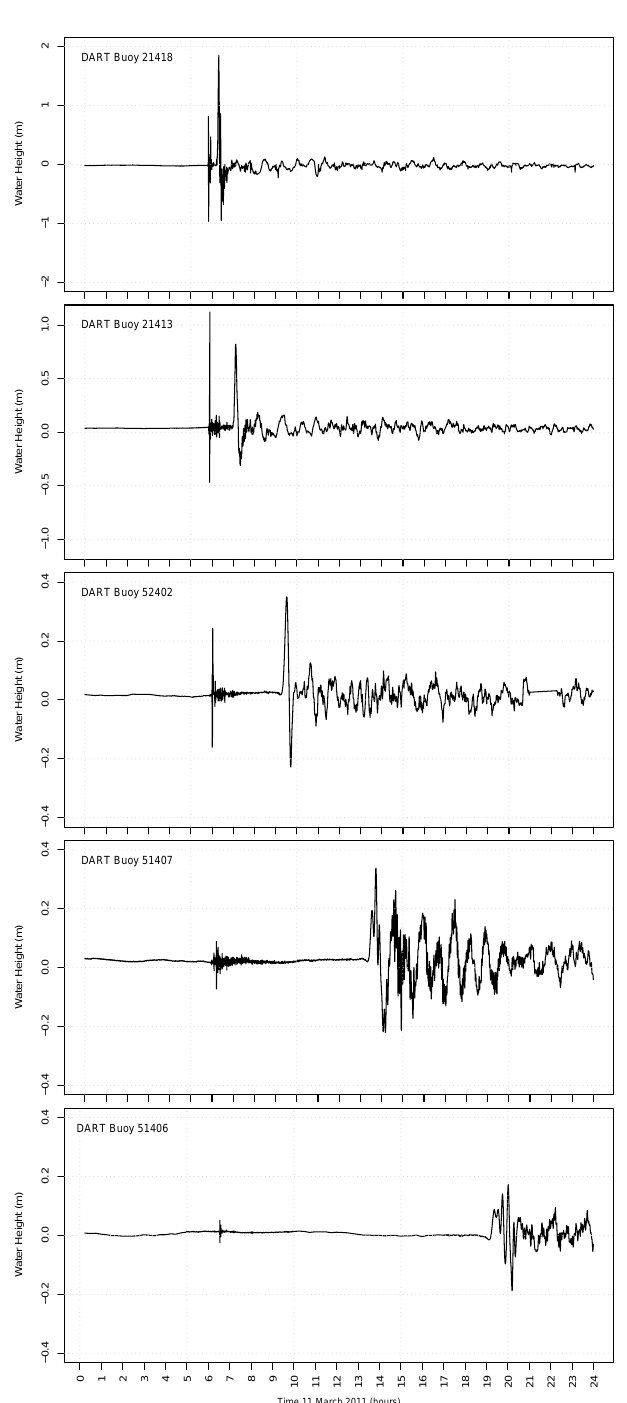
Figure 2. Wave height in meters for five DART tsunami buoys for 11 March 2011. The buoys are arranged in increasing distance from the epicenter. Data source: NOAA National Geophysical Data Cen- ter.